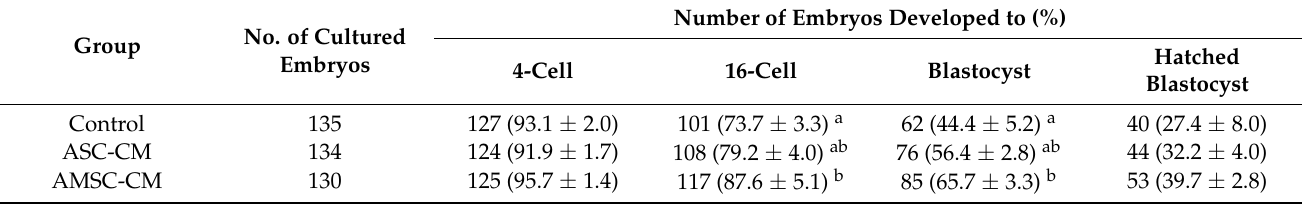
Experiments were repeated at least 3 times. a,b Mean ± SEM with different superscript letters indicate significant differences (at least p <